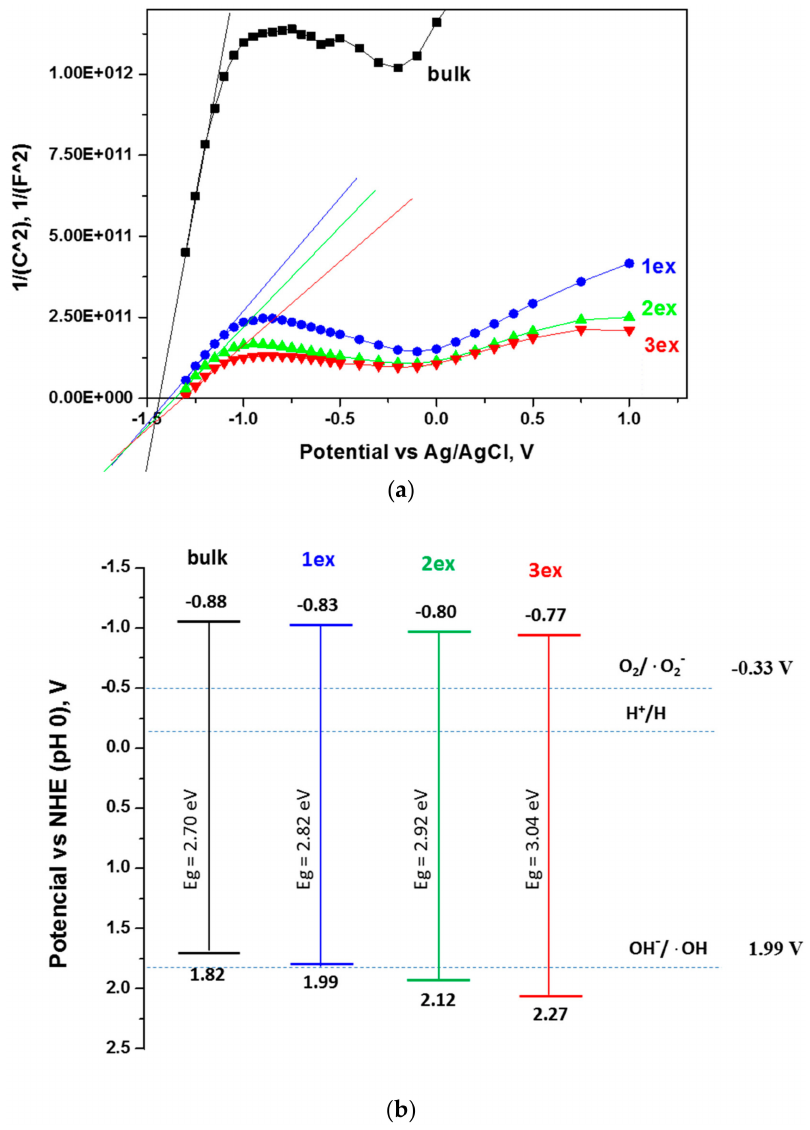
Figure 7. Mott–Schottky plots for frequency 100 Hz ( a ) and schematic presentation of the band gap potentials ( b ) of the bulk and exfoliated g-C 3 N 4